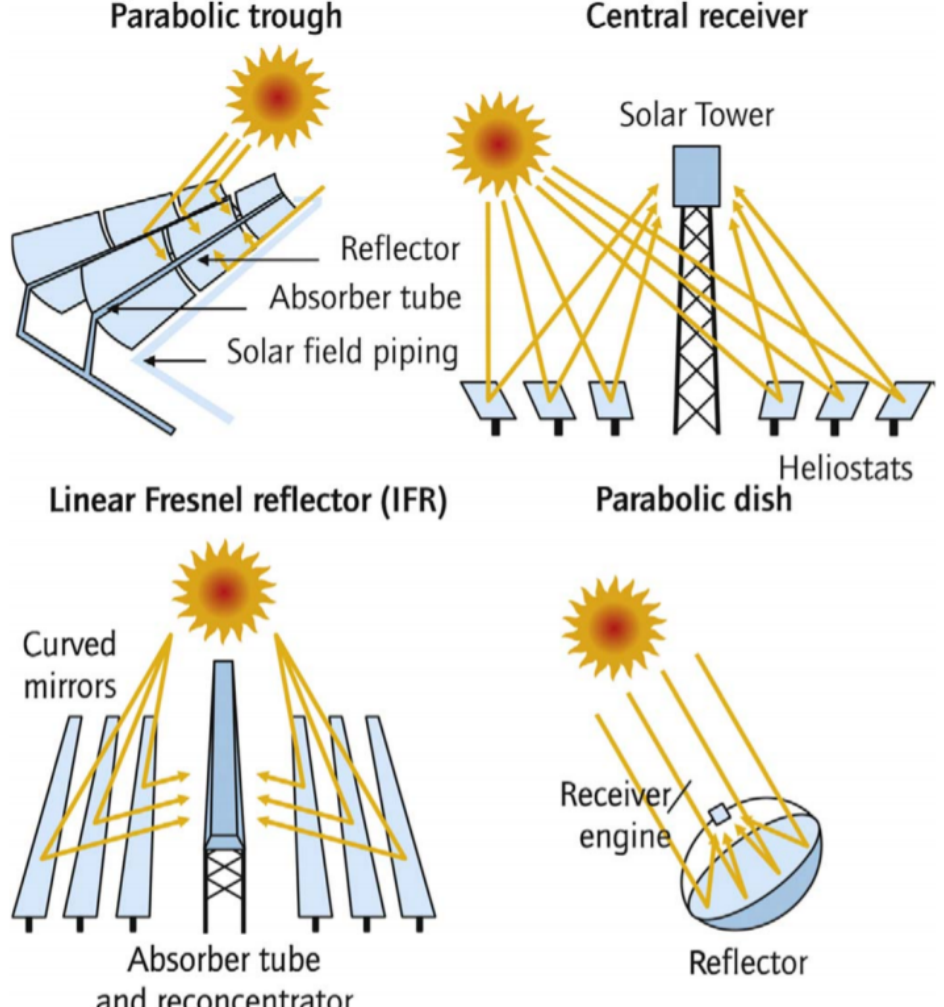
Figure 4. Main types of solar concentrators in solar fields. (Reprinted from [71] with permission of